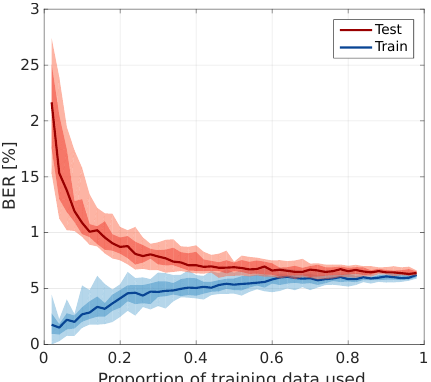
Figure 8. Learning curves for the hydrometeor-type model, show- ing the evolution of the train and test BER as a function of the num- ber of training samples used (100% = 2429 images). Dark areas correspond to the 25–75 percentile range computed over 20 itera- tions of random train-test splitting, light areas extend to the 10–90 percentiles, and bold lines are the